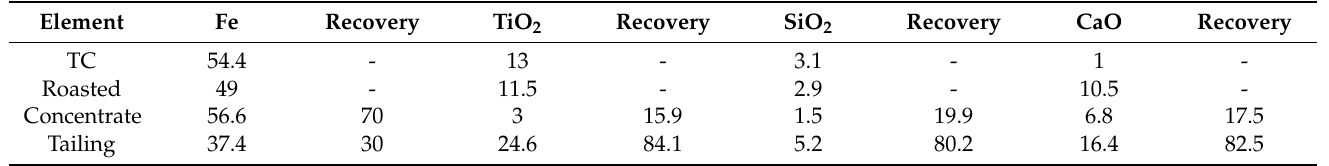
Table 2. Chemical analysis of experimental samples